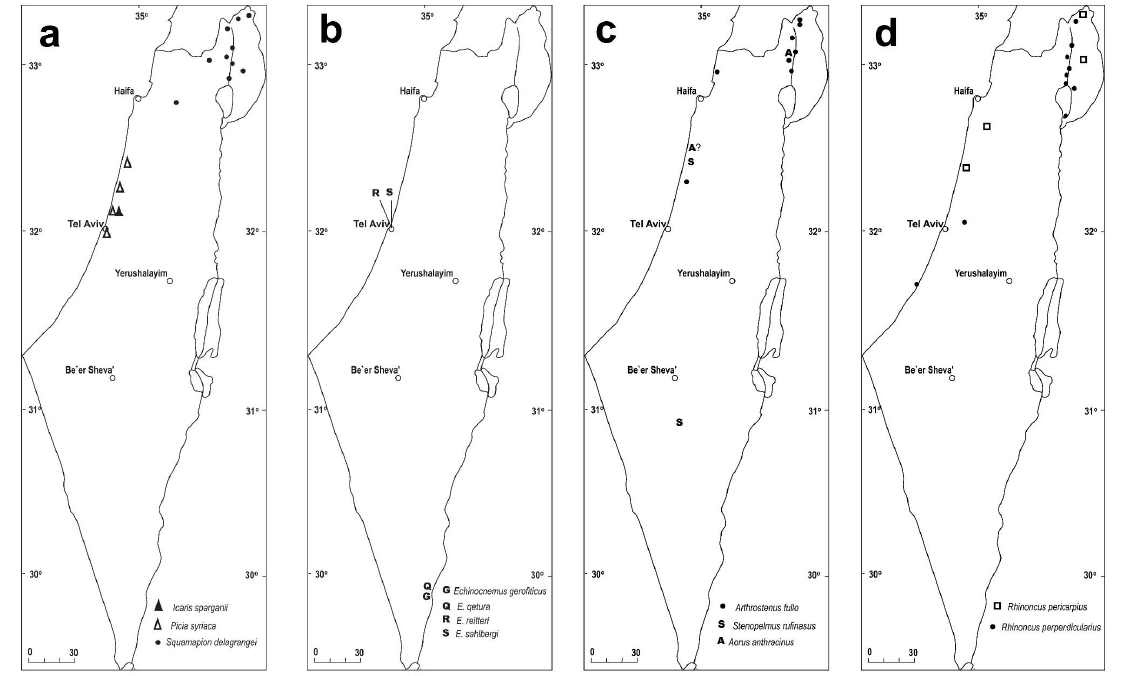
Figure 13. Distributional maps of ( a ) Icaris sparganii , Picia syriaca , Squamapion delagrangei ; ( b ) Echinocnemus reitteri , E. sahlbergi , E. gerofiticus , E. qetura ; ( c ) Arthrostenus fullo ; Stenopelmus rufinasus , Aorus anthracinus ; ( d ) Rhinoncus pericarpius , R. perpendicularis . Curculioninae Latreille, 1802 [60] Mecinini Gistel, 1848